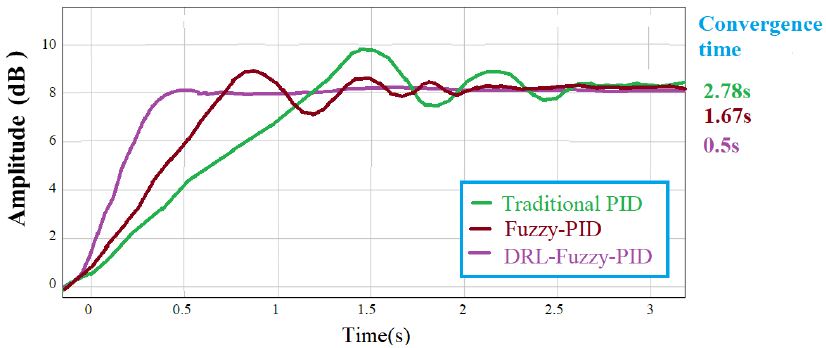
Figure 18. Comparison of the response curves of the (DRL-Fuzzy-PID) controller proposed in this study, Fuzzy-PID and traditional PID controllers .